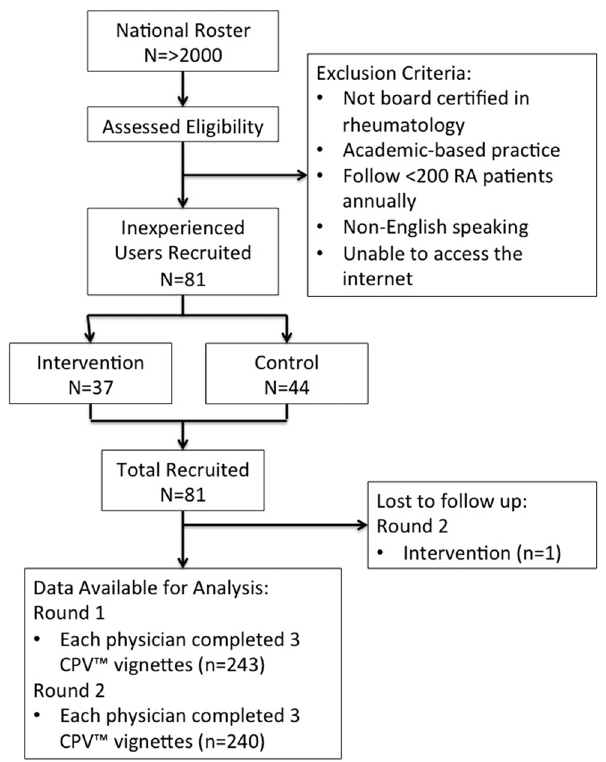
Figure 1. Flow diagram of sample selection.